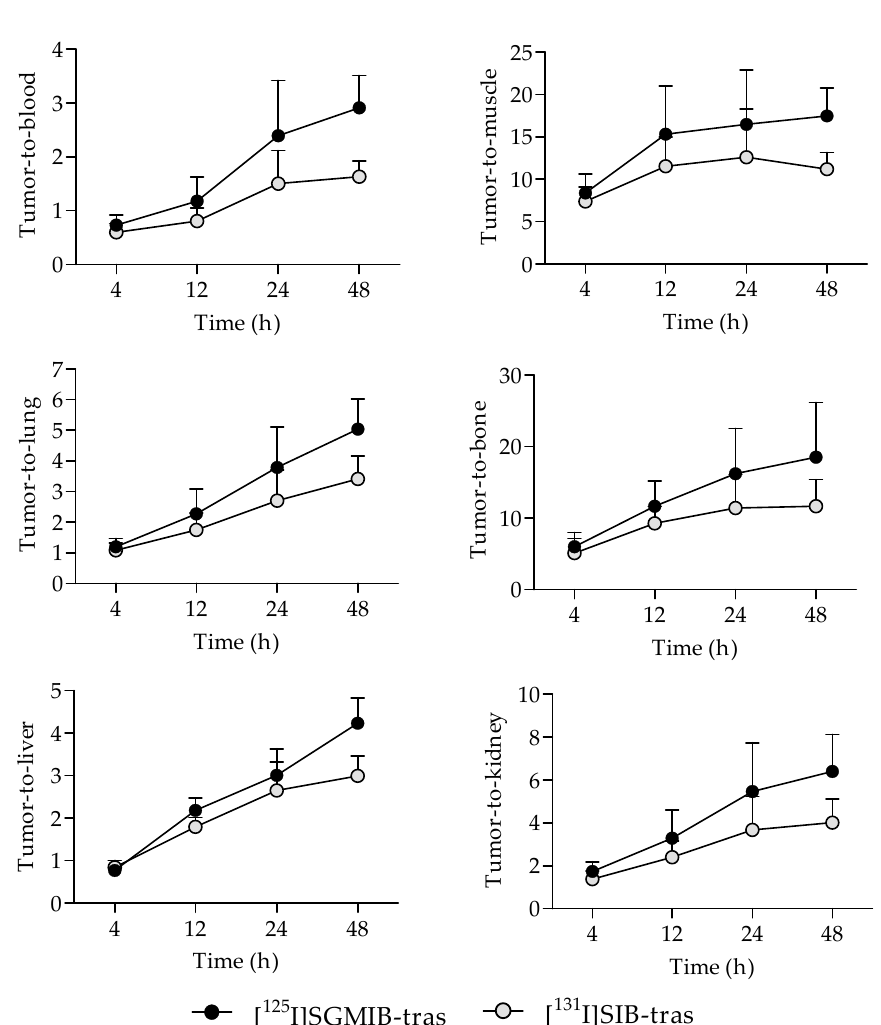
Figure 4. Comparison of the tumor-to-normal tissue ratios for [ 125 I]SGMIB-trastuzumab and [ 131 I]SIB-trastuzumab at 4–48 h after injection in NSG mice bearing subcutaneous BT474M1 xenografts.